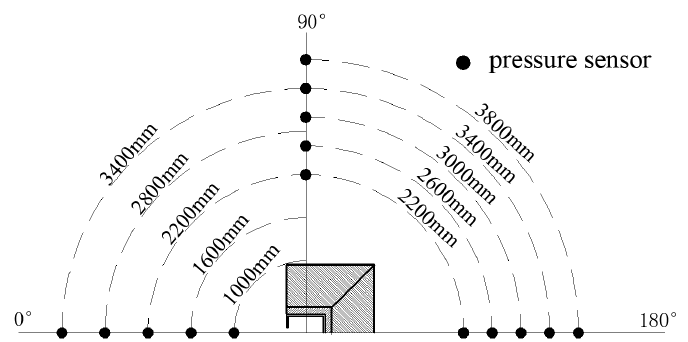
Figure 3. Sensor layout. Figure 3. Sensor